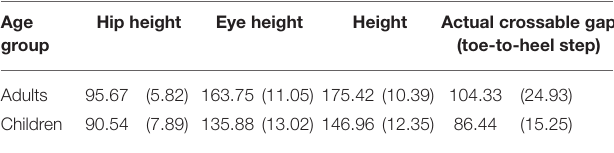
TABLE 3 | Means (SD) of body dimensions and actual crossable gap in cm for Experiment 2.